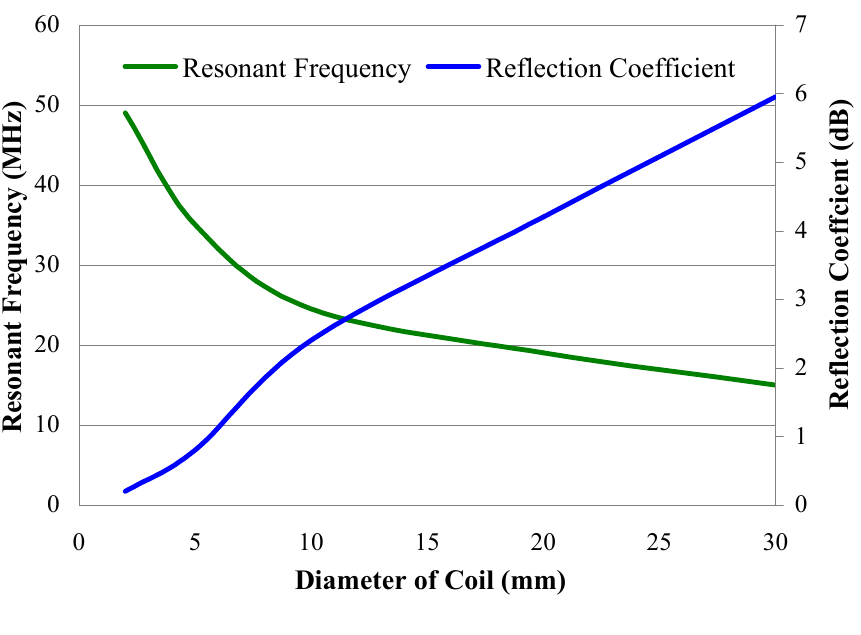
Figure 18. The effect the coil diameter has on the resonant frequency and reflection coefficient (related to signal strength) for a range of simple oscillating